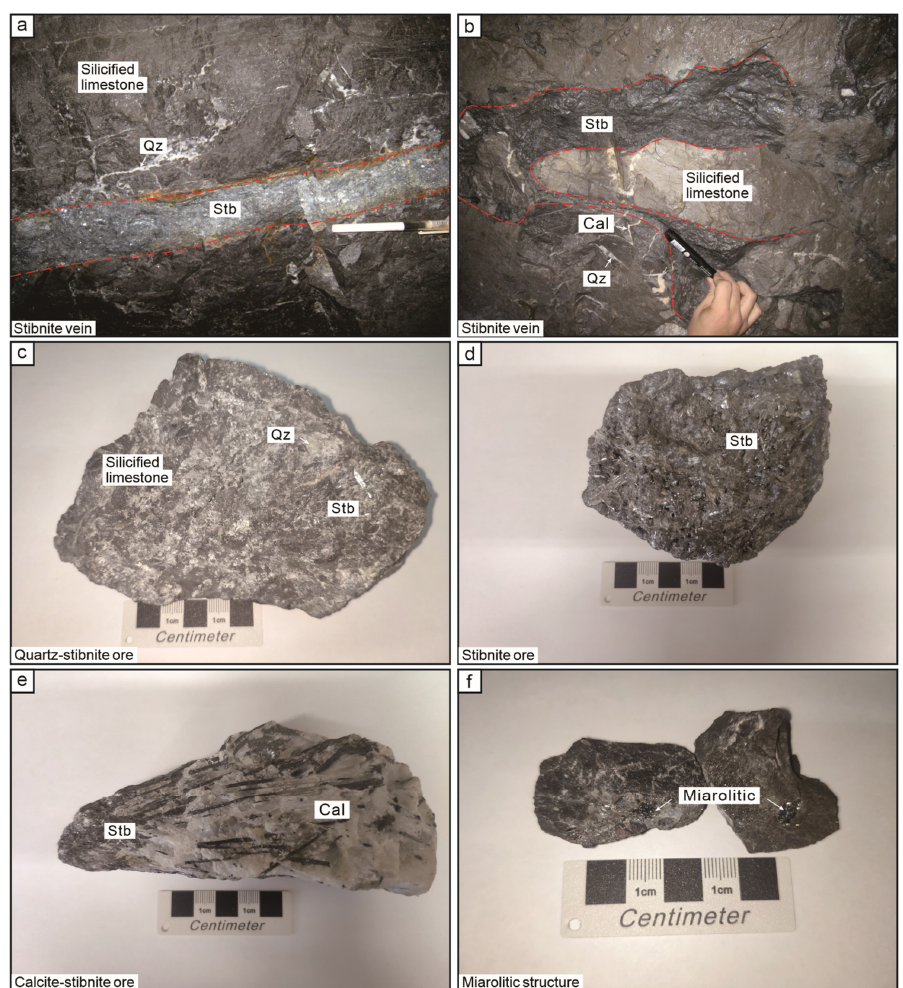
Figure 4. Representative photographs of orebodies and Sb ores in the Daocaowan Sb deposit. ( a , b ) Vein ‐ type orebodies hosted by silicified limestone; ( c ) Quartz–stibnite ores; ( d ) Massive stibnite ores; ( e ) Calcite–stibnite ore; ( f ) Miarolitic structure. Qz = quartz, Cal = calcite, Stb = stibnite. The Daocaowan Sb deposit has a simple mineral assemblage. The main metal miner ‐ als are stibnite and pyrite, and gangue minerals are mainly calcite, quartz, and dolomite (Figures 4–6). The ore structure is dominated by a disseminated and veined structure. It is worth noting that crystal hole structures can be found (Figure 6e,f). The mineralization of Daocaowan can simply divided into three stages according to field interpenetration and mineral paragenesis (Figure 7). The ore types are mainly quartz–stibnite type, quartz–cal ‐ cite–stibnite type, and calcite–stibnite type.